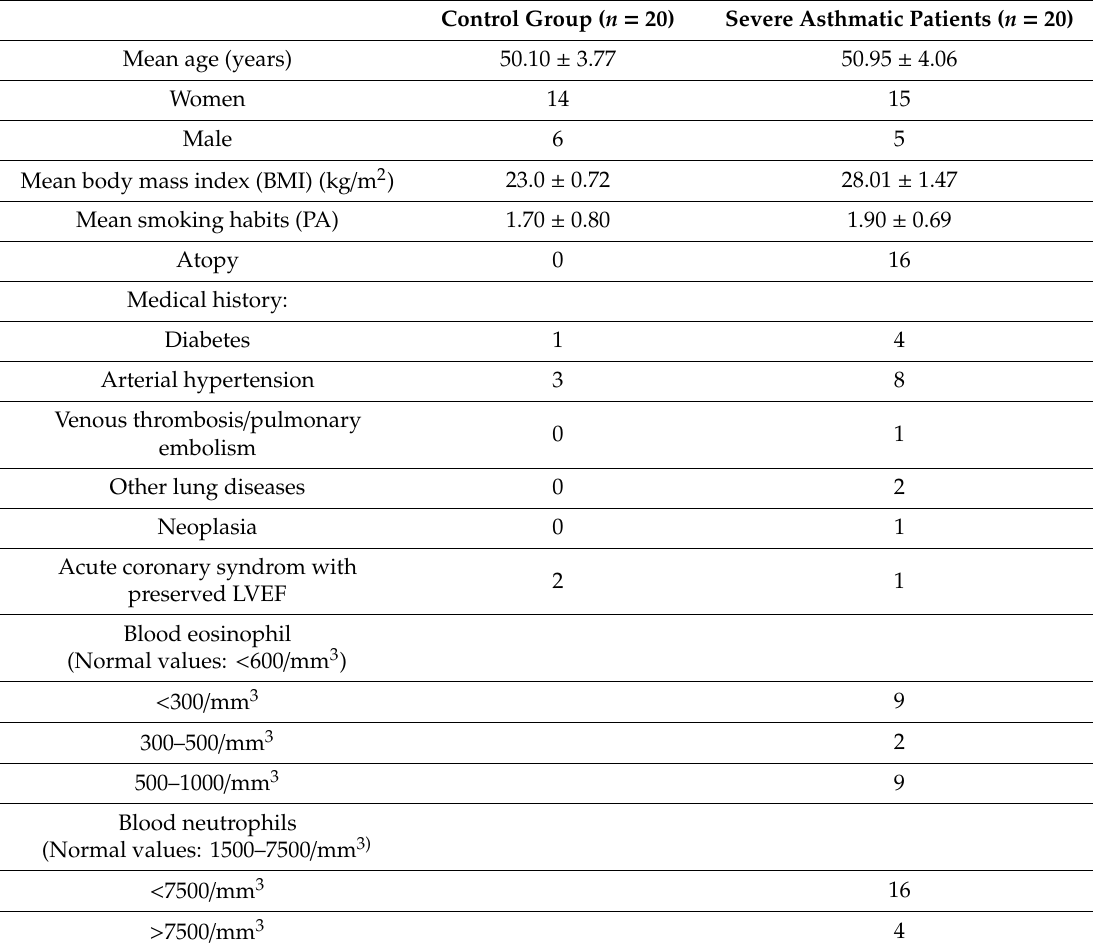
Table 1. Demographic, clinical, and biological characteristics of the